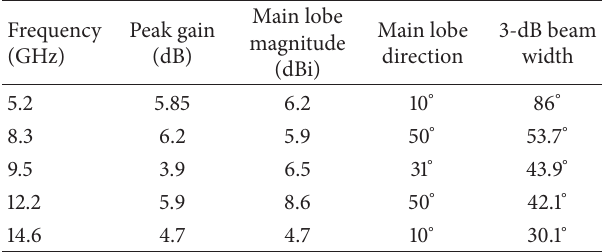
Table 1: The multiband DGS resonator performances.